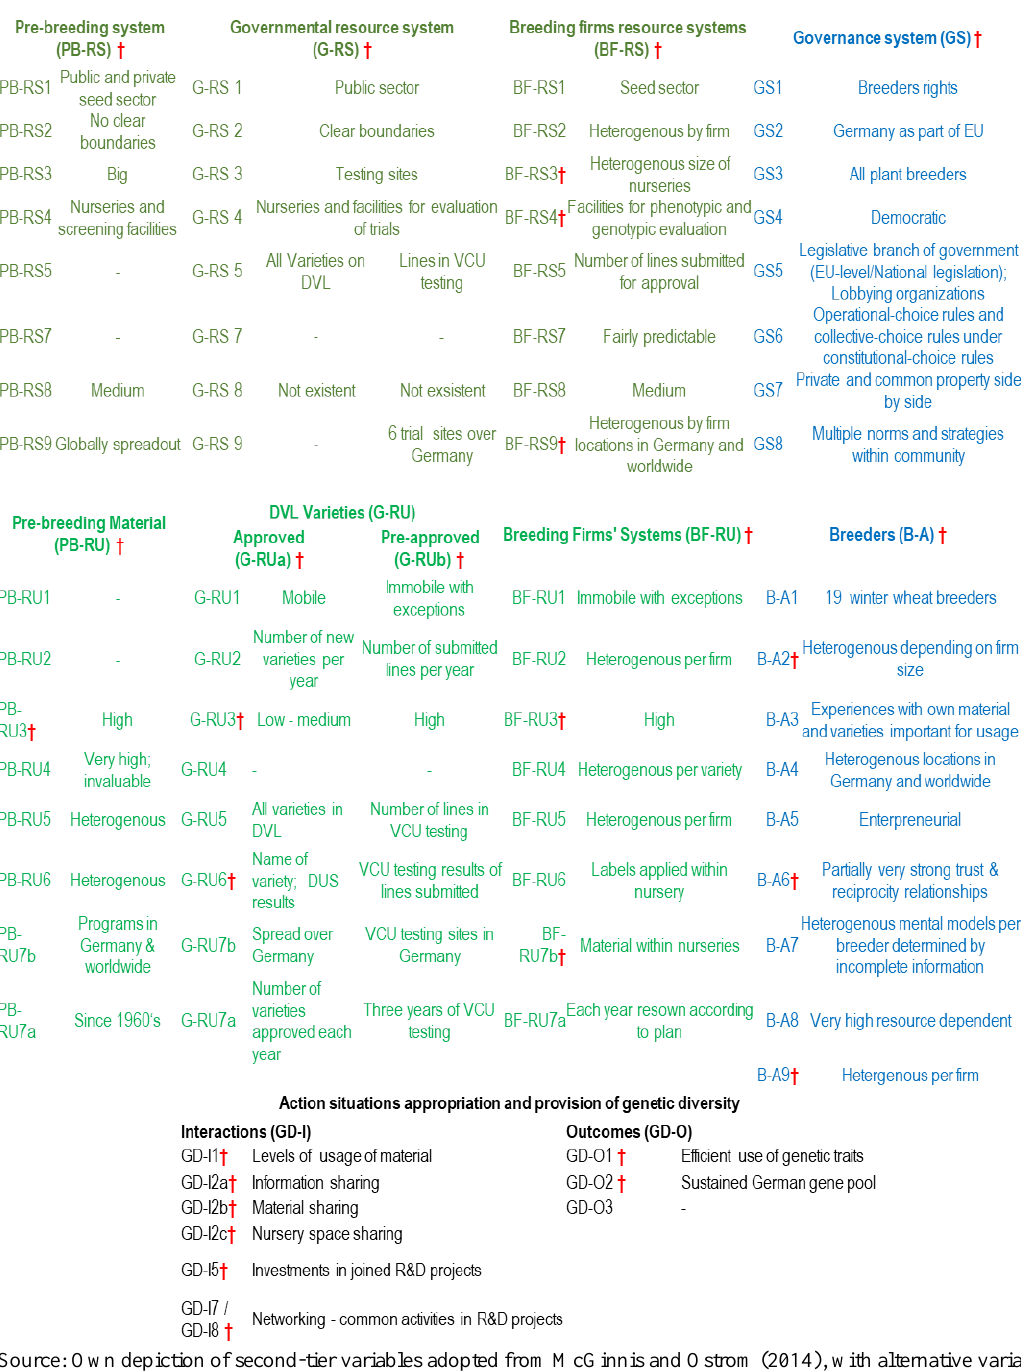
Figure A1.1: Second-tier SESF components for provisioning and appropriating genetic diversity in German winter